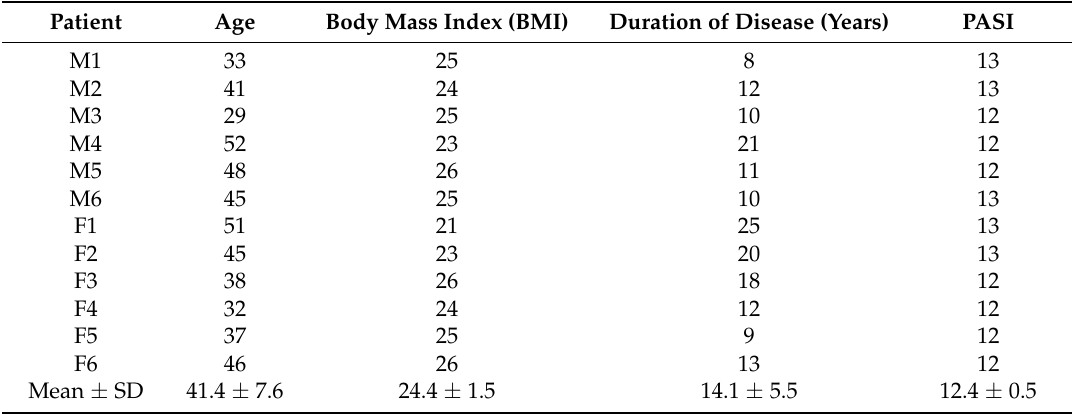
Table 1. Demographic and clinical data of psoriatic patients involved in the